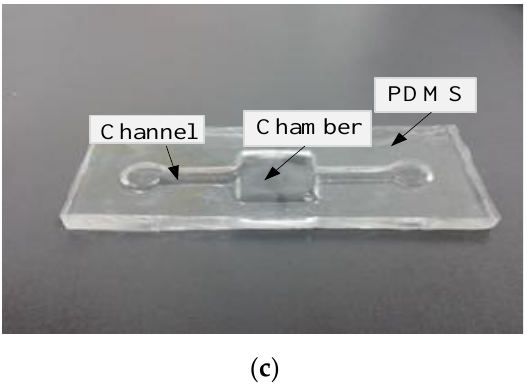
Figure 2. Mold for microfluidic chamber; ( a ) Structural dimension; ( b ) Rapid prototyping mold; ( c ) microfluidic chamber.